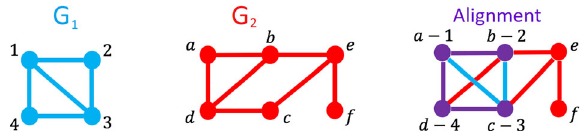
Fig. 1 A schematic depiction of a 1-to-1 Pairwise Global Network Alignment (PGNA). The input graphs are G 1 (blue, with fewer nodes), and G 2 (red). The network alignment can be depicted itself as a network with two types of nodes (purple and red) and three types of edges (purple, blue, and red). Aligned nodes and edges are purple, depicting a mix of red and blue. Unaligned nodes and edges retain the color of the graph they came from. Note that in the aligned network, two common measures of topological network similarity can easily be interpreted visually: EC = ∣ purple edges ∣ / ∣ purple + blue edges ∣ , while S 3 = ∣ purple edges ∣ / ∣ edges of all colors between purple nodes ∣ similarity in the absence of sequence similarity, we distinguish between Resnik values that allow all types of evidence ( “ allGO ” ) vs. those that disallow any evidence based on sequence ("NOSEQ ” ). Table 1 (bottom) lists the evidence codes we disallow in the latter case. Topological similarity of a global alignment between two networks . The topological similarity of an alignment between two networks can be scored in many ways, including quantifying edge overlap 17,45,46 , node “ importance ” 47 , graphlet similarity 16,48,49 , graph edit distance 50,51 , and graph spectra 52 . While some work has been conducted to compare how alignment strategies and objective functions each independently affect the biological relevance of an alignment 46,53 , our companion paper 40 performs the fi rst comprehensive, level-playing fi eld study to compare a large number of topological measures for their ability to recover biological information. Figure 1 provides a schematic example of